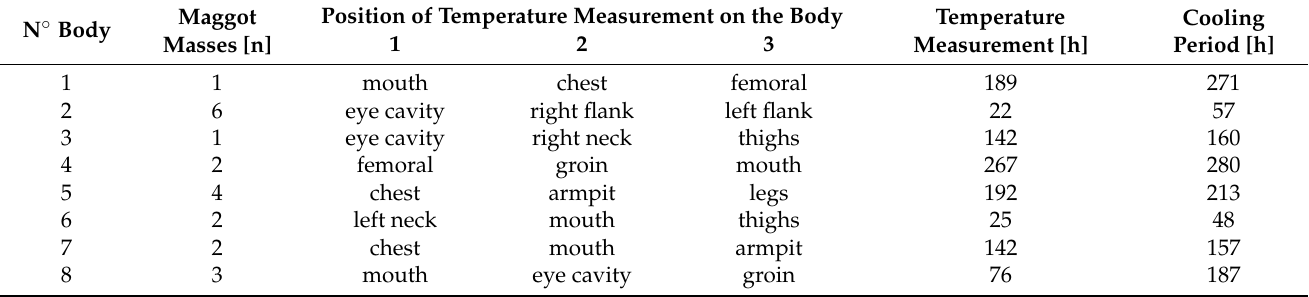
Table 1. Information of the bodies (n = 8) used for the temperature profiles in the walk-in cooler. “temperature measurement” refers to the actual duration of the measurement with the temperature logger on the bodies, while “cooling period” describes the time between the arrival of the body at the institute, i.e., beginning of cold storage, and the collection of the body by the mortician, i.e., end of cold storage. N ◦ is the number of body and n the sample